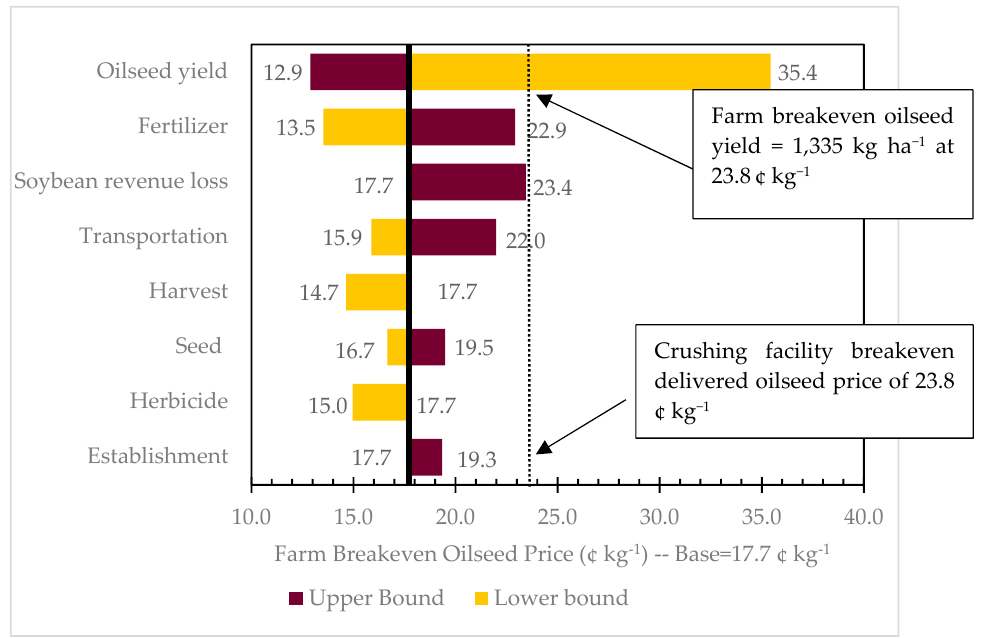
Figure 2. Breakeven and one-way sensitivity analysis of minimum pennycress prices (profit = 0) for farmers to produce and transport oilseed feedstock from the field to the crushing facility. Notes: Input assumptions for the base, lower bound, and upper bound scenarios are presented in Table 1.